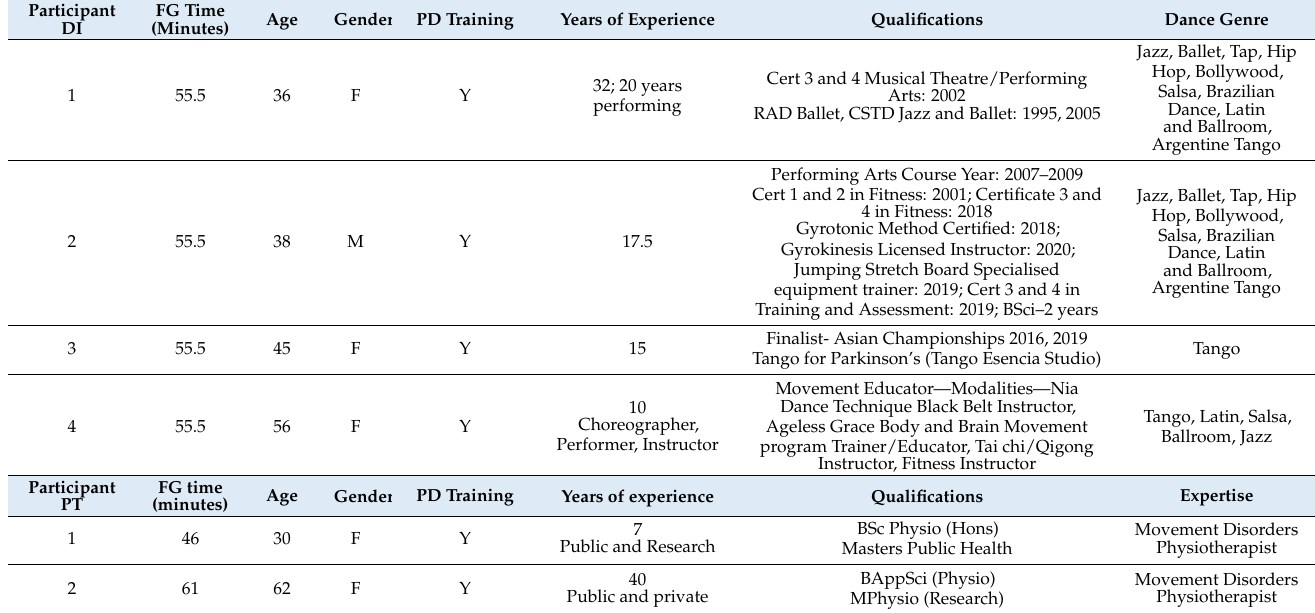
Table 2. Dance instructor (DI) & physiotherapist assessor (PT) demographic